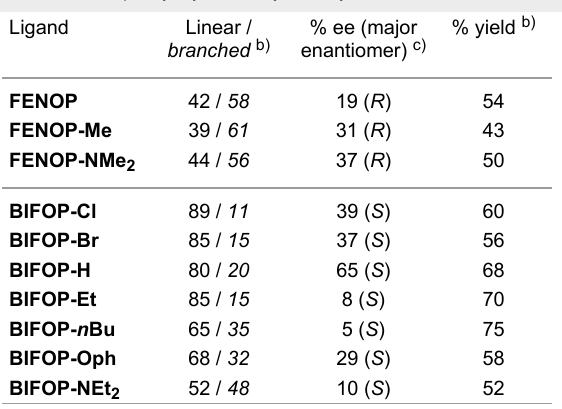
Table 1: FENOP- and BIFOP-Pd-catalysts in enantioselective allylic substitutions of phenylallyacetate by dimethylmalonate. a) Ligand Linear / branched b)